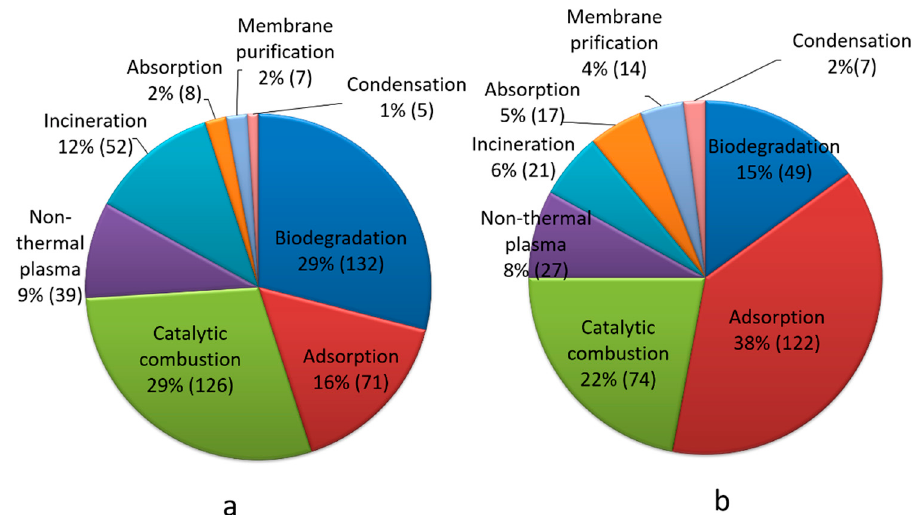
Figure 8. The ratios of VOCs elimination technologies used in China ( a ) and other countries ( b ) (the numbers in the brackets are the numbers of companies using the related technologies). Reprinted with permission from [51], copyright 2012, CNKI.